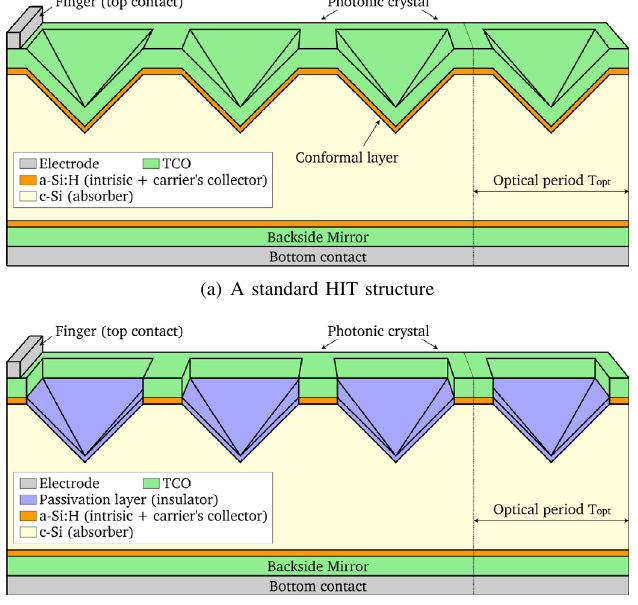
Fig. 1. HIT thin film solar cells with a top photonic crystal (inverted pyramids).